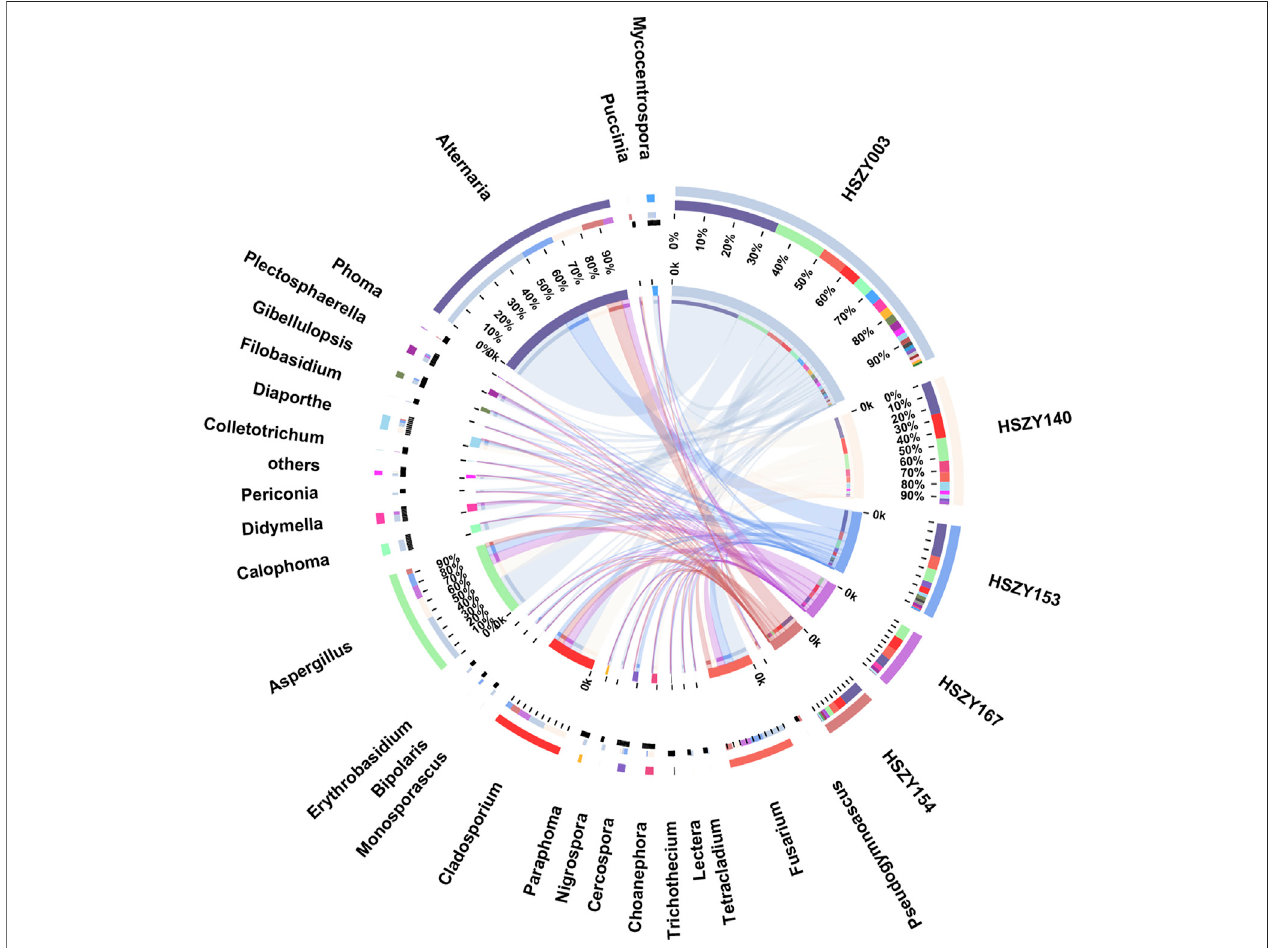
FIGURE4| Thefungalcommunitydistributionforeachsampleatthegenuslevel.ThedatawerevisualizedusingCircos.Thelefthalf-circleindicatesthedistribution ratio of species in different samples at the genus level: the outer ribbon represents the species, the inner color of the ribbon represents different groups, and the length represents the proportion of the sample for a particular genus. The right half-circle indicates the species composition in each sample: the color of the outer ribbon representssamplesfrom differentgroups, thecolor oftheinner ribbon representsthe composition ofdifferent species in each sample, and the lengthof theribbon represents the relative abundance of the corresponding